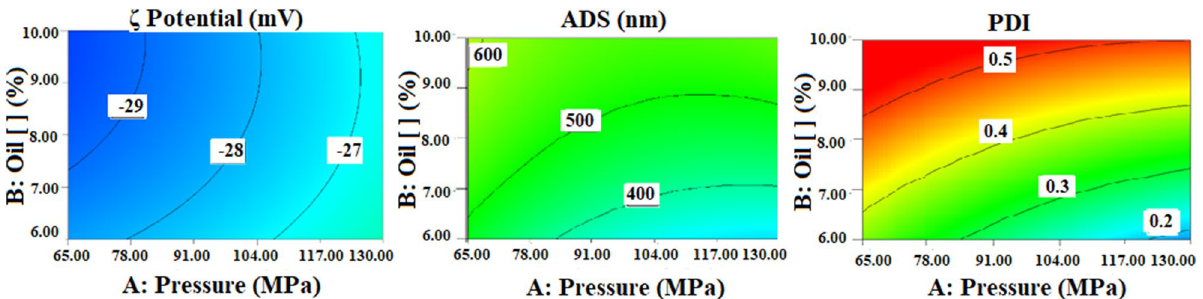
Figure 1. Graphs of the models of ζ , ADS and PDI in function of pressure (x axis) and oil concentration (y